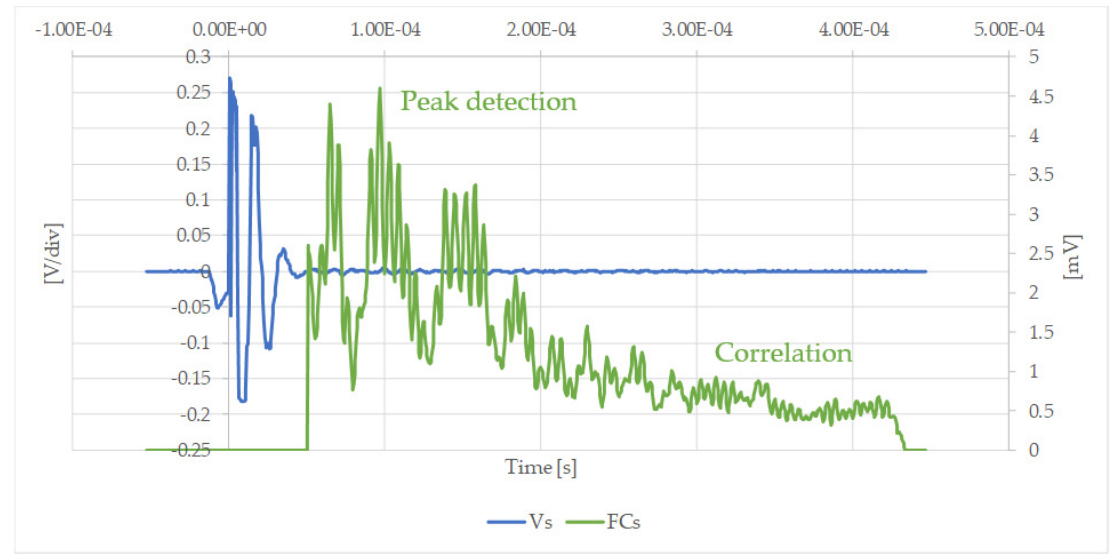
Figure 25. New sensor results: Experimental signal in the receiver, Vs [V], and filtered signal, FCs [mV] after using the correlation filter with a partial silicone blockage in position A-4.